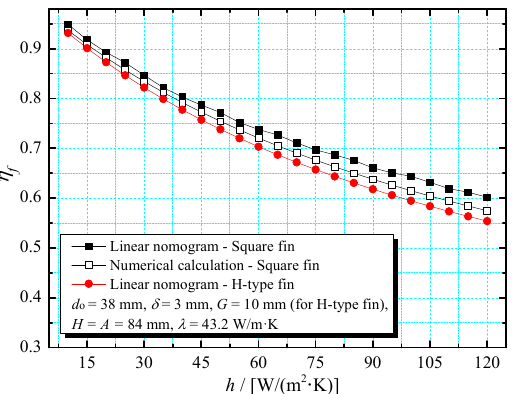
Figure 13. Influence of the surface heat transfer coefficient on the fin efficiency of H-type and square fins.